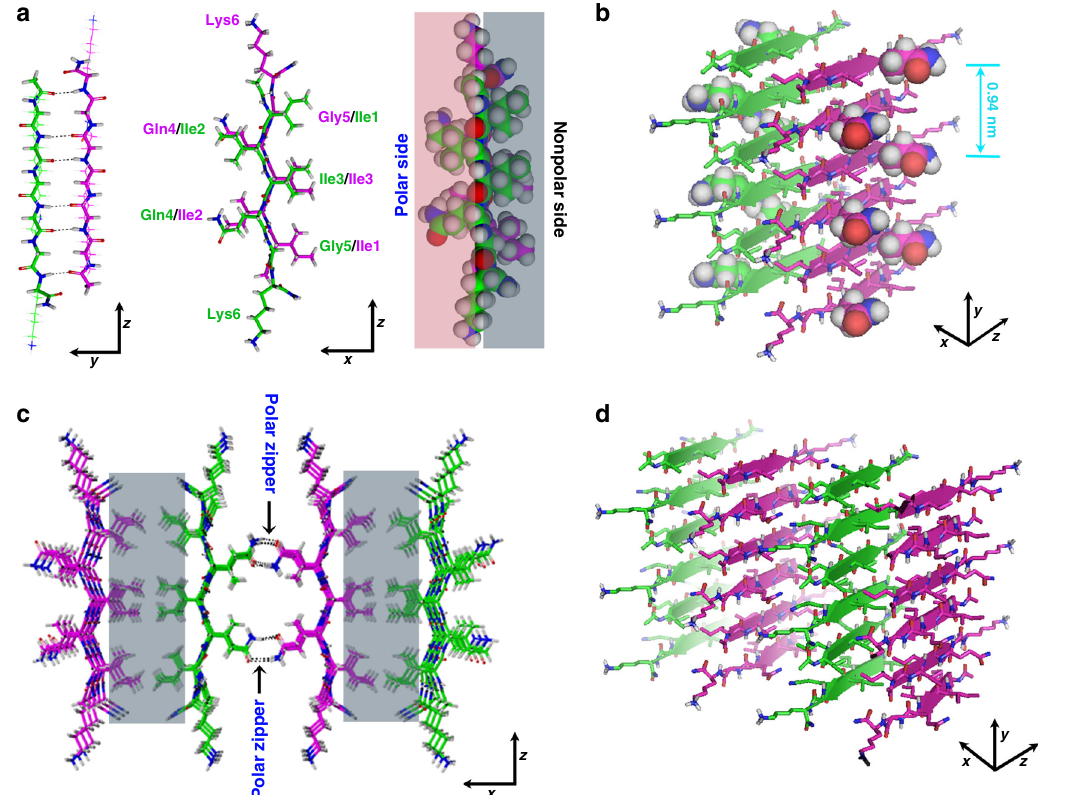
Fig. 7 Schematic illustration of the self-assembly of Ac-I 3 XGK-NH 2 (X = Q, S, and N) into nanoribbons. Carbon atoms are shown as purple or green, oxygen as red, nitrogen as blue, and hydrogen as gray. a Two β -strands pack in an anti-parallel mode with one-residue shifting. The protruding side chains of Ile1, Ile3, and Gly5 constitute the nonpolar face (gray colored) of the β -sheet while the side consisting of the side chains of Ile2, Gln4 (or Ser4 or Asn4), and Lys6 acts as the polar face (pink colored). b A pair of β -sheets stabilized by hydrophobic adhesions of two nonpolar faces (back-to-back), in which the backbone of each β -strand is shown as a broad arrow, with protruding X side chains separated by a distance of ~9.4 Å along a sheet. c The formation of polar zippers (black arrows) at the polar interface between neighboring β -sheets. The nonpolar interface is colored gray. c , d The combination of polar zippers and hydrophobic adhesion intermeshes β -sheets into wide ribbons, as shown from different